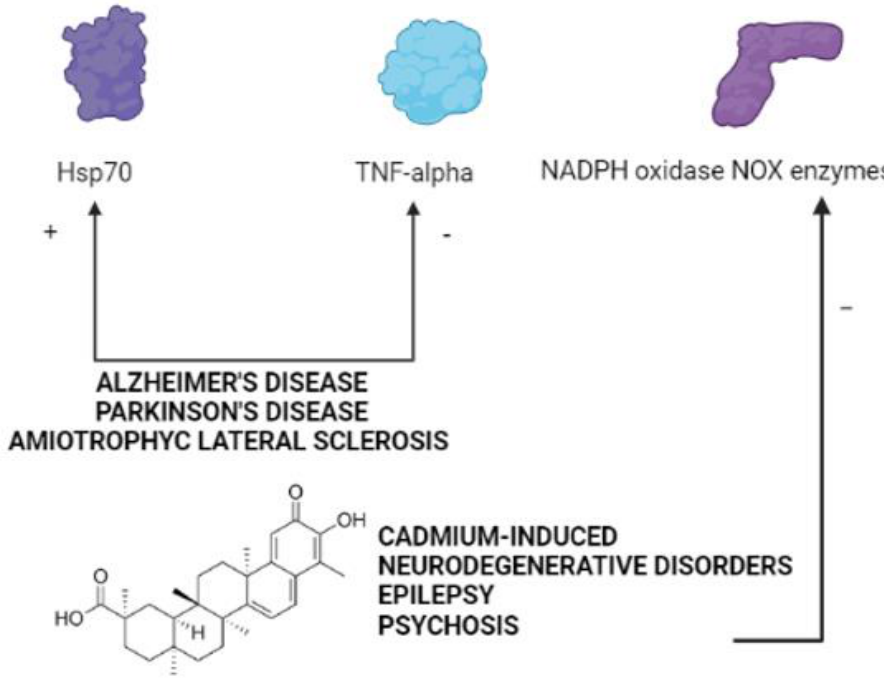
Figure 2. Common molecular targets of celastrol in psychiatric and neurological disorders (created in BioRender.com (accessed on 27 July 2021)).